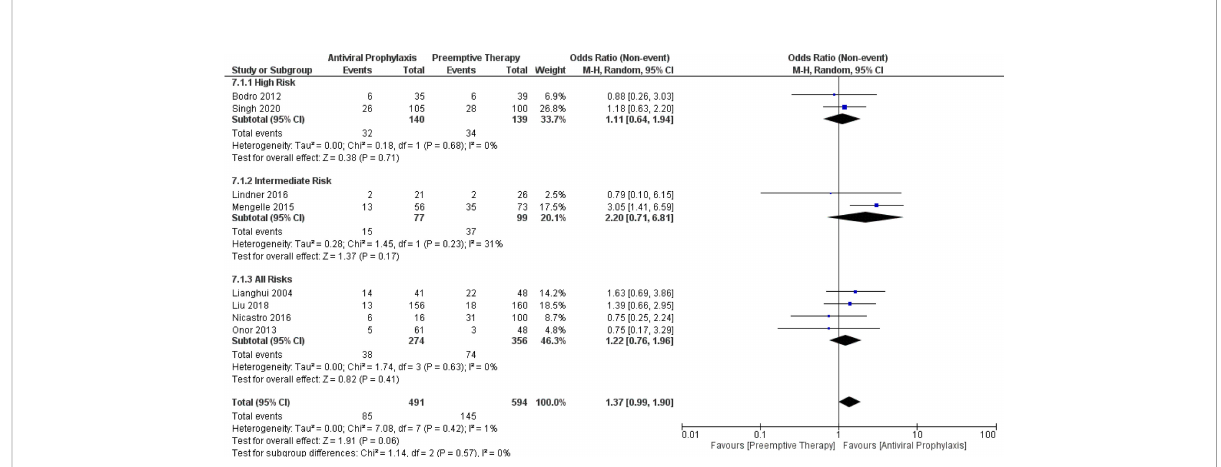
Incidence of all mortality The overall pooled incidence of mortality in the overall LT recipients, high-risk group, and intermediate-risk group receiving antiviral prophylaxis and preemptive therapy was estimated as 10.9% vs. 13.1% (10 vs. 10 studies and 832